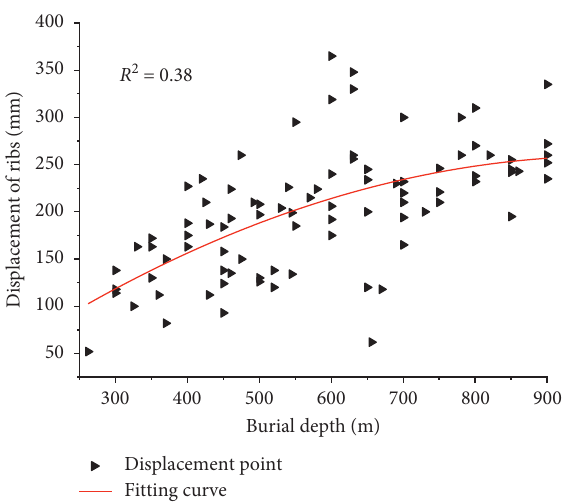
Figure 13: Displacement of ribs (45 th day).